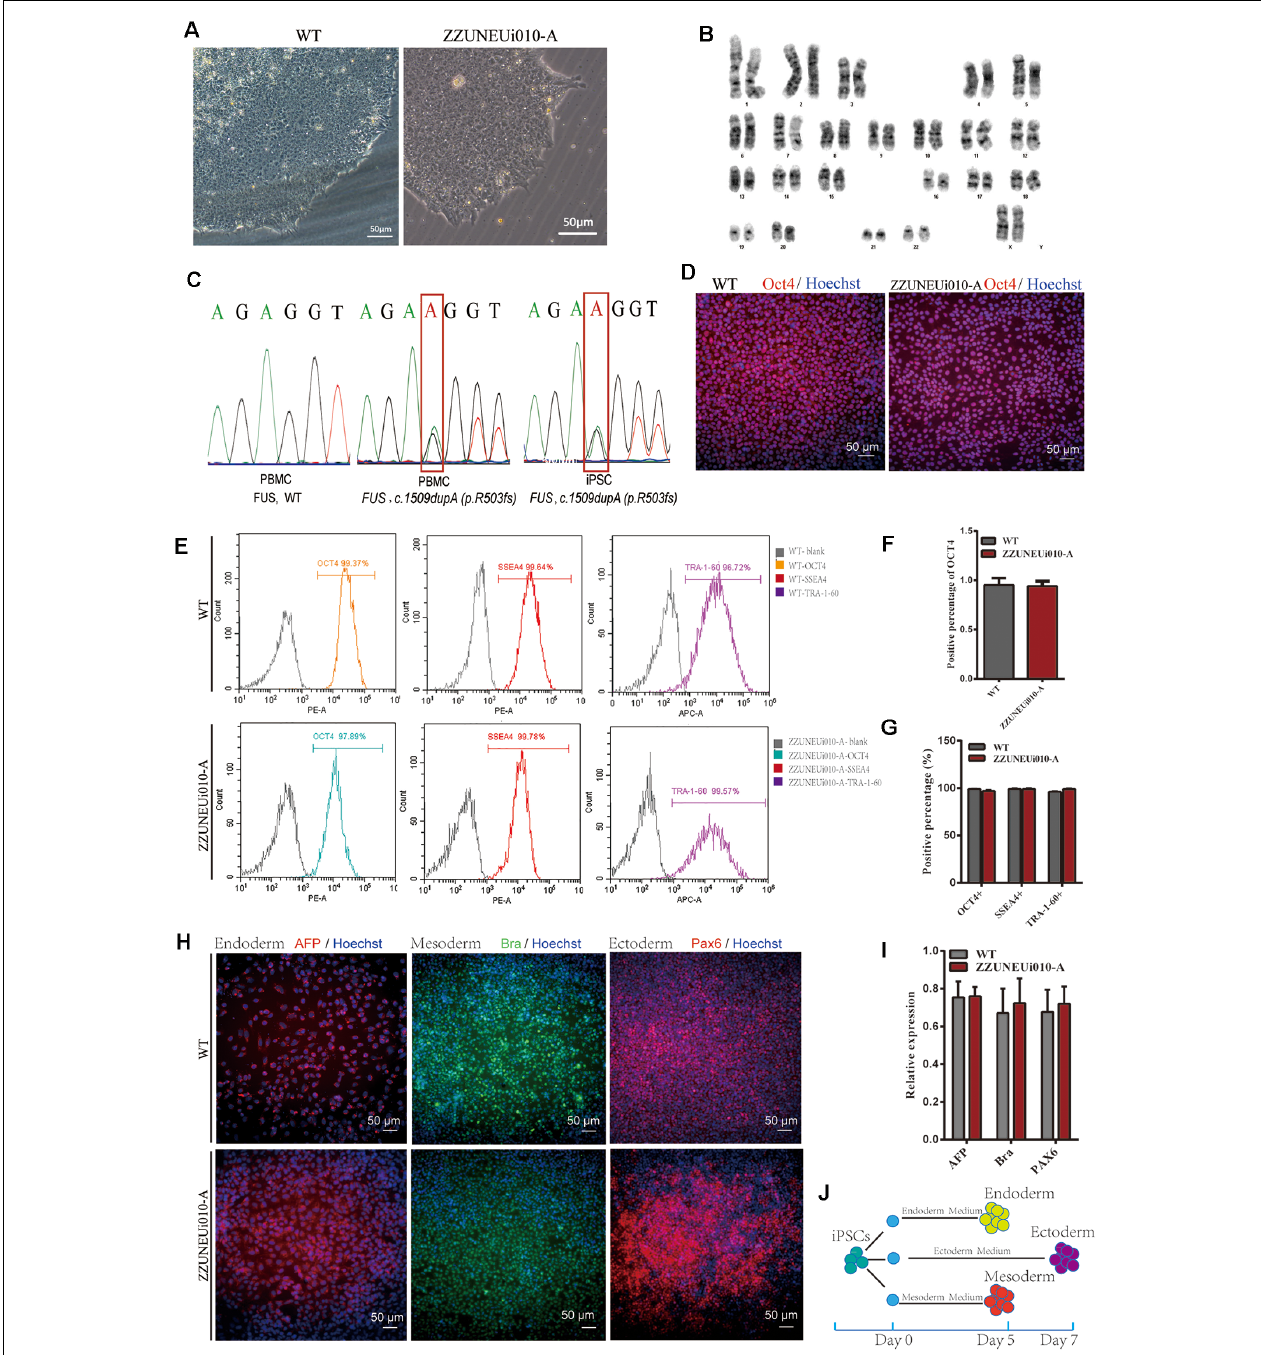
FIGURE 1 | Pluripotency identification and trilineage differentiation of the human-induced pluripotent stem cells (hiPSCs). (A) Brightfield images of ZZUNEUi010-A clones ( × 10). (B) Karyotype analysis of ZZUNEUi010-A, 46, XX, without chromosomal aberrations. (C) Illumina and Sanger sequencing of PBMCs and ZZUNEUi010-A from this patient detected the same fused in sarcoma ( FUS ) mutation (c.1509dupA:p.R503fs). (D) Immunofluorescence images showing that ZZUNEUi010-A colonies stained strongly for the pluripotency marker OCT4. (E) Flow cytometry showed that the hiPSCs were strongly positive for the pluripotency markers OCT4 (97.89%), SSEA-4 (99.78%), and TRA-1-60 (99.57%). (F) There was no significant difference between ZZUNEUi010-A and WT in positive staining rate for OCT4 ( n = 3 views, p > 0.05). (G) There was no significant difference between ZZUNEUi010-A and WT in positive rate for those markers OCT4, SSEA-4, and TRA-1-60 ( n = 3, p > 0.05). (H) On day 5, the cells differentiated from the hiPSCs stained strongly for AFP and brachyury respectively, while at day 7 the differentiated cells showed strong PAX6 staining. (I) There was no significant difference between ZZUNEUi010-A and WT in positive staining rate for the three embryonic markers ( n = 3 views, p > 0.05). (J) Schematic diagram of triploblastic differentiation experiment.